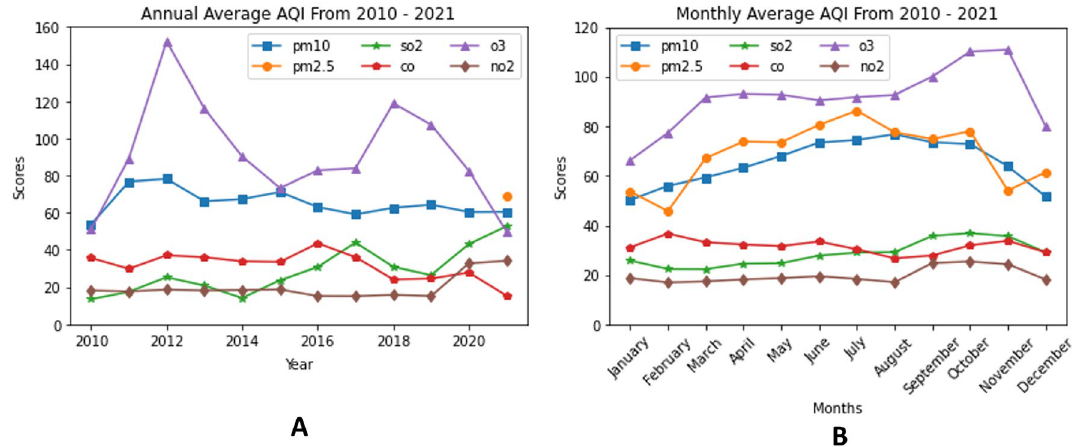
Figure 3. The ( A ) annual and ( B ) monthly average AQI in Jakarta from 2010 to 2021.